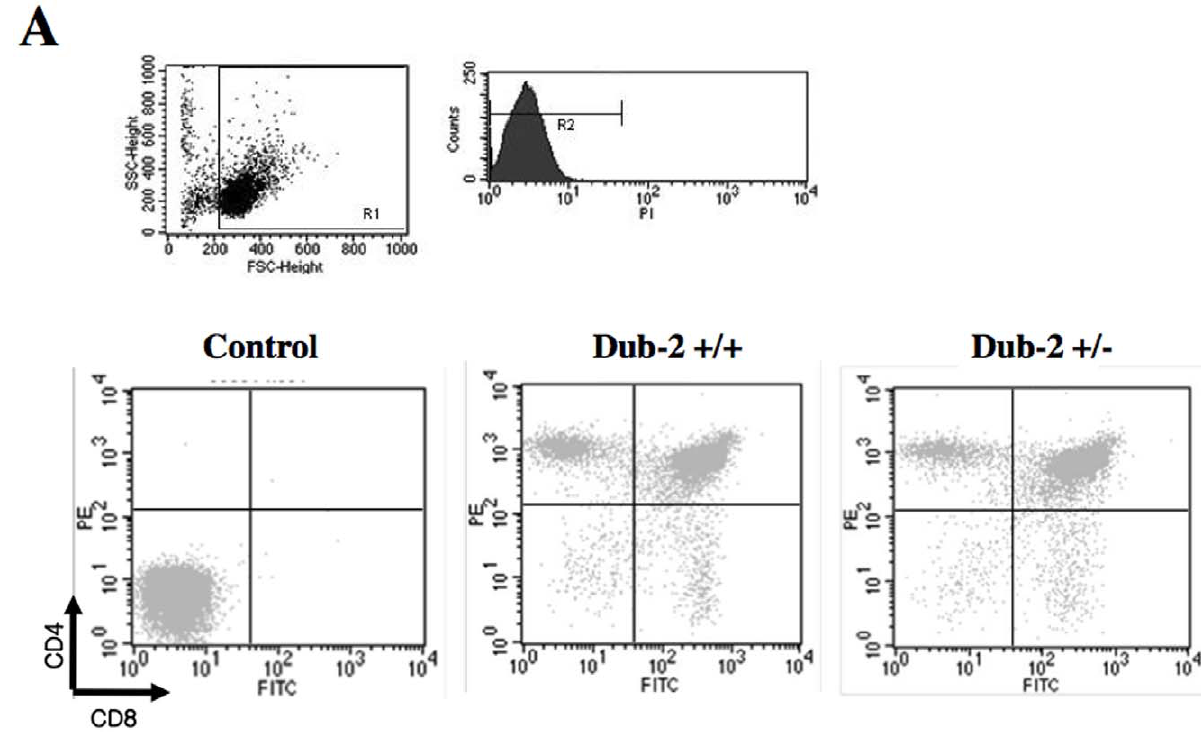
Figure 3. Lymphoid cell population in the thymus and spleen of 5 weeks old animals was analyzed by FACS. A) Thymocytes were harvested from Dub-2 + / + and Dub-2 + / 2 mice with the indicated genotypes, fixed with ethanol, and stained with FITC-conjugated anti-CD8, and PE- conjugated anti-CD4. B) The graph shows the ratio of lymphoid cells with CD4 + or CD8 + . The ratio of thymocytes from Dub-2 + / + was calibrated as 100%. C) Splenocytes were harvested from Dub-2 + / + and Dub-2 + / 2 mice with the indicated genotypes, fixed with ethanol, and stained with FITC- conjugated anti-B220, and APC-conjugated anti-CD3. D) The graph shows the ratio of lymphoid cells with CD3 + or B220 + .